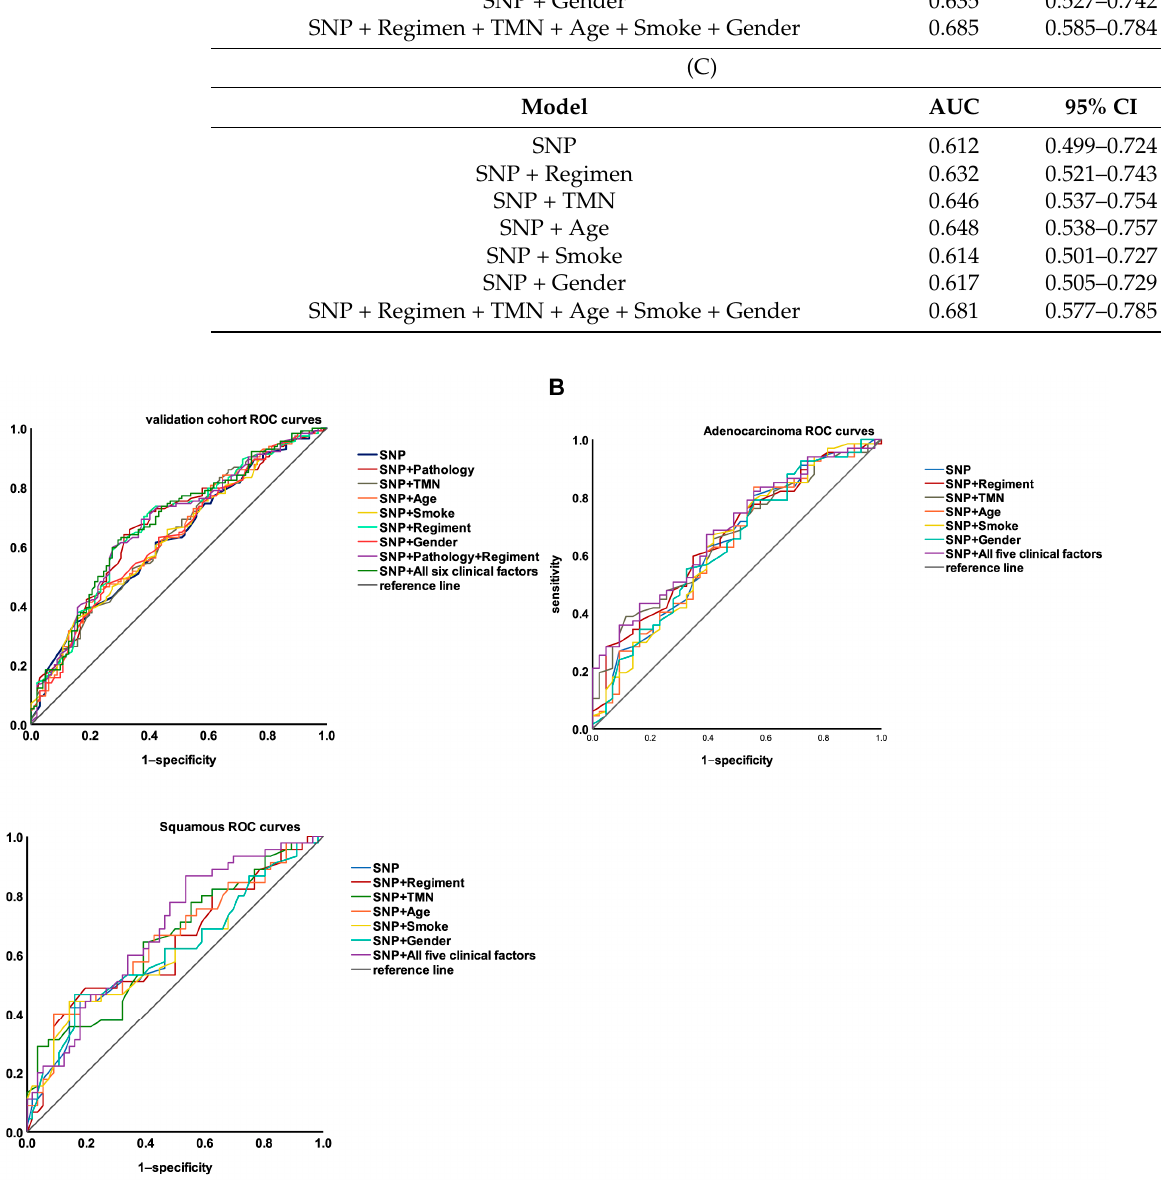
Figure 6. ( A ) The performance of the platinum–based chemotherapy response models established by SNPs combined with different clinical factors in the validation cohort. ( B ) The performance of the platinum–based chemotherapy response models established by SNPs combined with different clinical factors in the validation cohort of adenocarcinoma samples. ( C ) The performance of the platinum–based chemotherapy response models established by SNPs combined with different clinical factors in the validation cohort of squamous carcinoma samples. Table 4. (A) The AUCs of models established by SNPs combined with different clinical factors in the discovery cohort. (B) The AUCs of models established by SNPs combined with different clinical factors in the discovery cohort of adenocarcinoma samples. (C) The AUCs of models established by SNPs combined with different clinical factors in the discovery cohort of squamous carcinoma sam- ples.